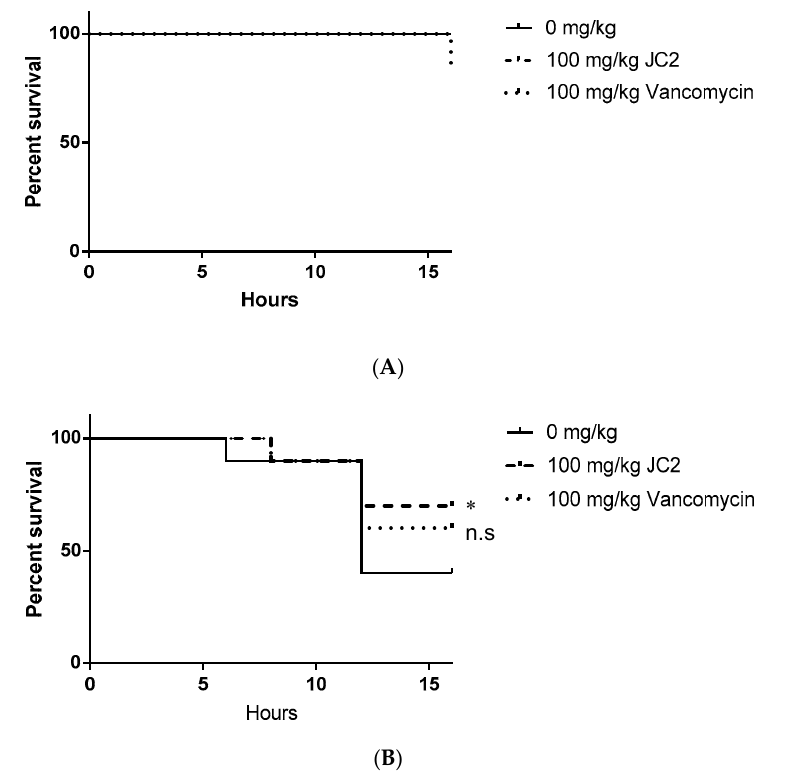
Figure 6. Survival curves of Galleria mellonella ( A ) uninfected worms treated with a single dose of DMSO, 100 mg · kg − 1 JC2 or 100 mg · kg − 1 vancomycin and ( B ) worms infected with 10 4 CFU S. aureus UAMS-1 infected worms treated with a single dose of DMSO, 100 mg · kg − 1 JC2 or 100 mg · kg − 1 vancomycin 1 h post-infection ( n = 10 per group); * p -value < 0.25; n.s., not significant (log-rank test).